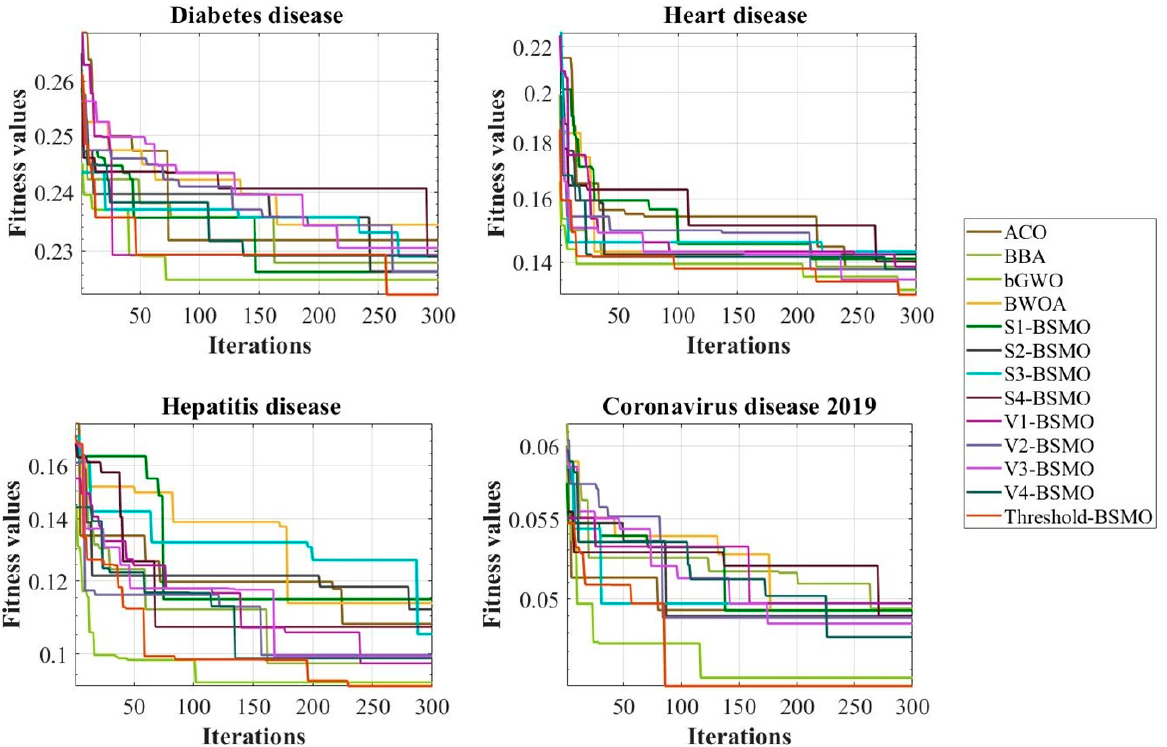
Figure 4. Convergence comparison of the BSMO and comparative algorithms.